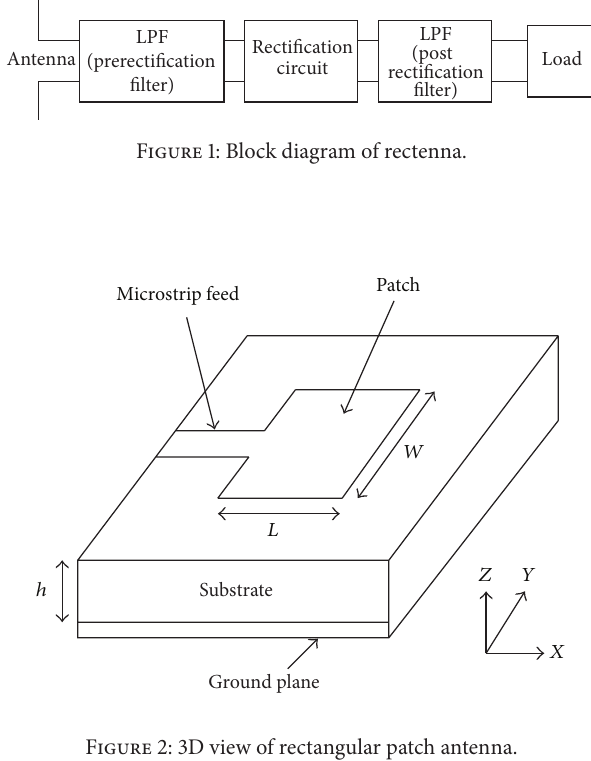
Figure 2: 3D view of rectangular patch